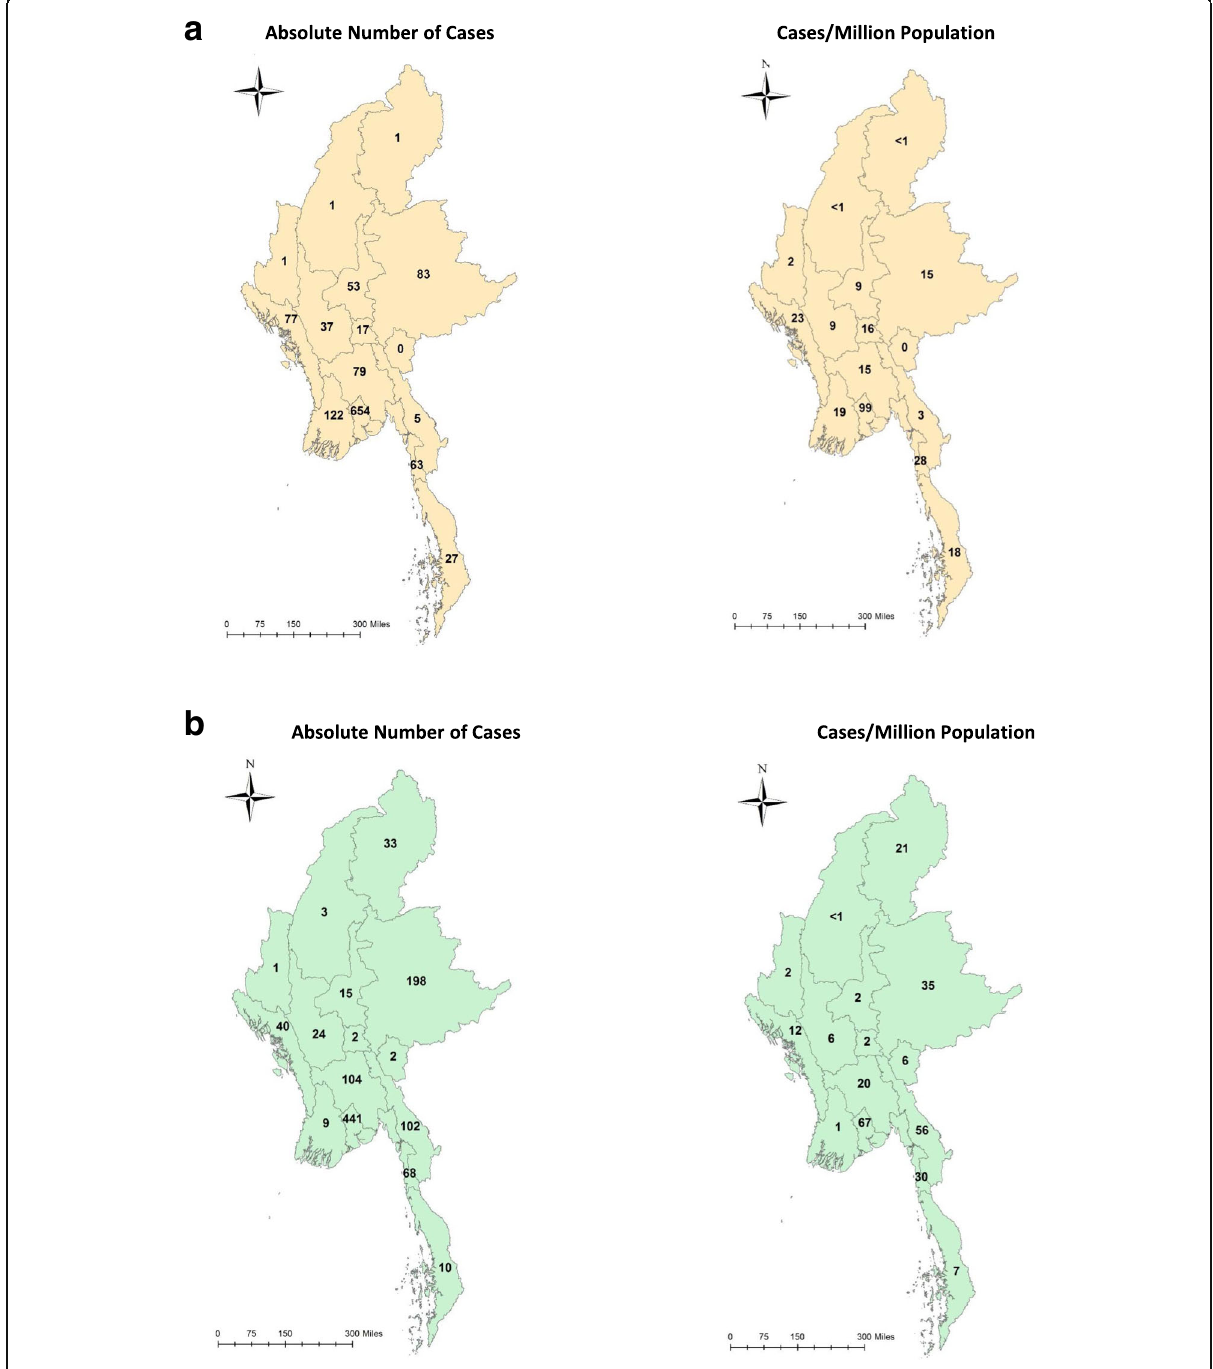
Fig. 4 Geospatial distribution of reported measles cases in Myanmar in 2017 and 2018. a Absolute number of cases and number of cases per million population in 2017. b Absolute number of cases and number of cases per million population in